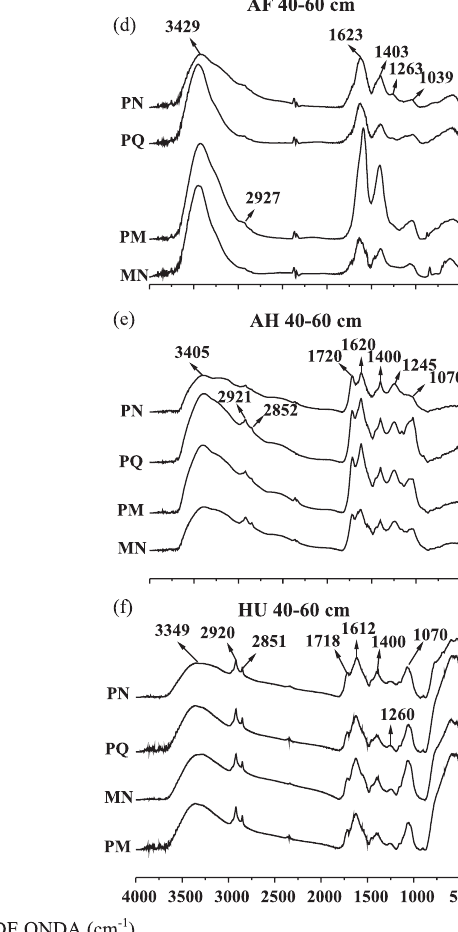
Figura 1. Espectros de FTIR das frações de: ácidos fúlvicos (AF) (a), ácidos húmicos (AH) (b) e humina (HU) (c) da camada de 0–5 cm e de AF (d), AH (e) e de HU (f) da camada de 40–60 cm de Latossolo Vermelho distroférrico típico sob ambientes de pastagem nativa (PN), pastagem nativa queimada (PQ), pastagem nativa melhorada com calcário e adubação (PM) e mata nativa